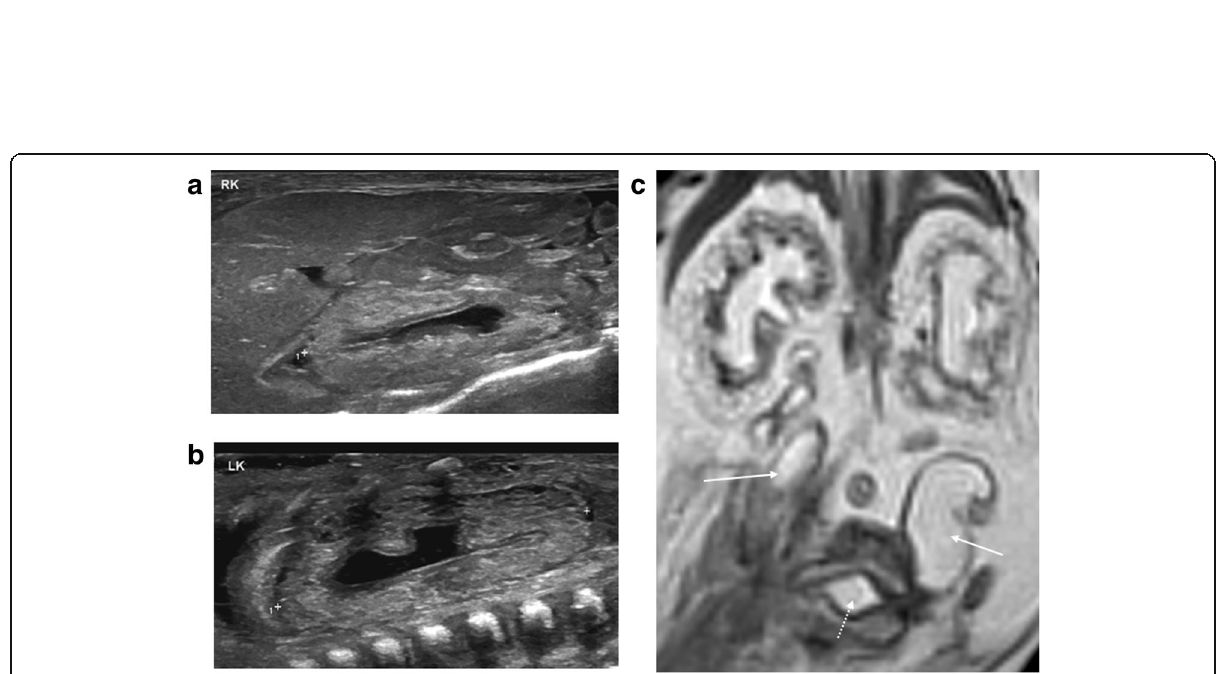
Fig. 18 Dysplastic renal appearances in a foetus at 21 weeks gestation, seen as a result of bladder outflow obstruction. Post-mortem imaging was performed 4 days after termination of pregnancy. On the sagittal post-mortem ultrasound images of the right ( a ) and left ( b ) kidneys, there is loss of the normal corticomedullary differentiation with hyperechoic renal cortices and mild pelvicalyceal dilatation. The corresponding post-mortem T2 weighted MRI study in coronal plane ( c ) confirms the same findings as ultrasound, and also reveals bilateral dilated and tortuous ureters (solid arrows) leading to a partially collapsed urinary bladder (dotted